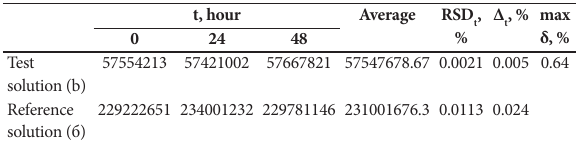
Table 10. Stability data of quinabut.